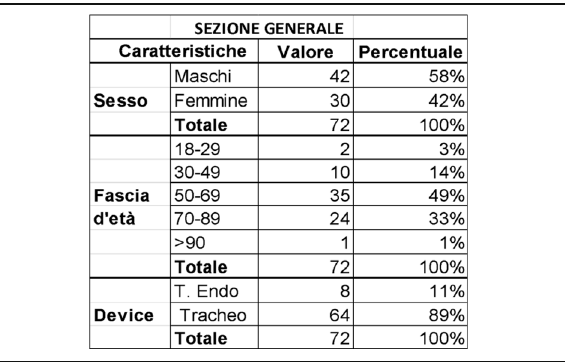
Table 1 (abstract A167). Sezione Generale, caratteristiche dei pazienti